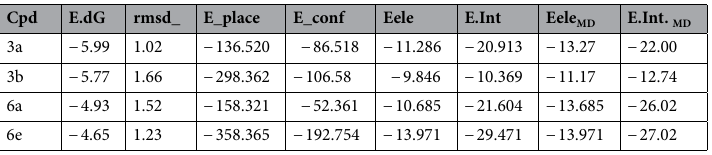
Table 1. Simulated molecular docking energies (kcal/mol) of the tested ligands. Ed.G. final free binding energy, E_conf. binding energy for the ligand-conformer, E_place binding energy of the ligand-receptor, E.Int. ligand-receptor affinity interaction energy, E.ele ligand-receptor electrostatic interaction, RMSD root mean square deviation of the docking pose compared to the co-crystal ligand position, E.Int MD interaction energy obtained from molecular dynamics, E.ele electrostatic interaction obtained from molecular dynamics.